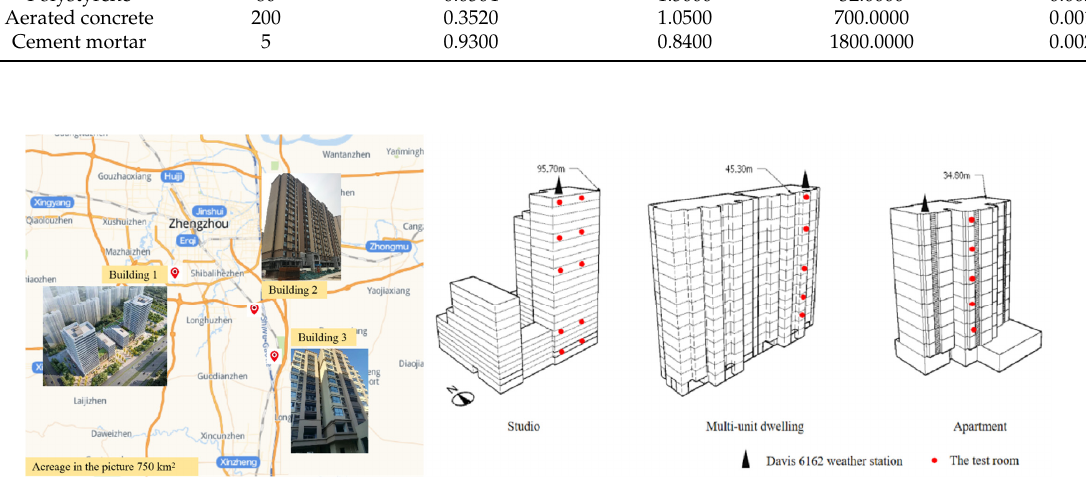
Figure 2. Locations, photographs, and shapes of three buildings.